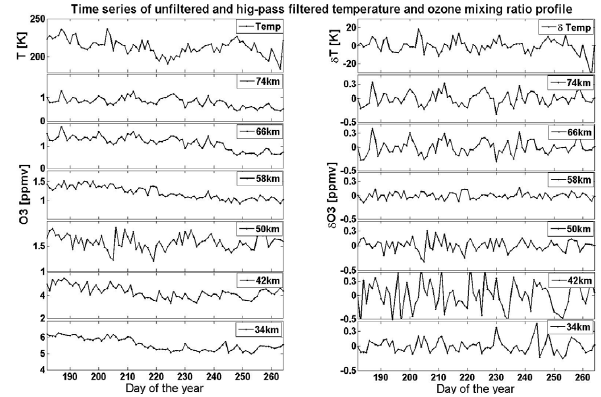
Fig. 1. Time series of temperature at 87km (top panel) and the ozone mixing ratio at selected altitude levels (lower 6 panels). Left: raw (unfiltered) data; right: filtered